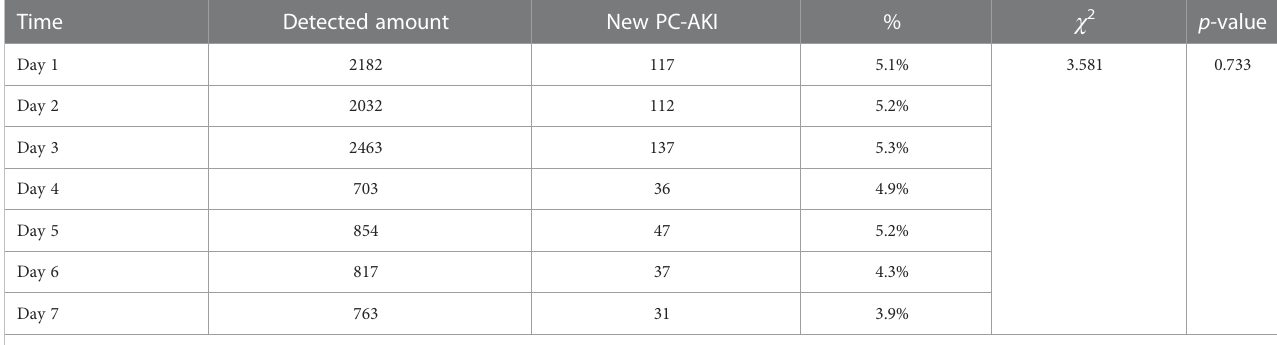
PC-AKI, post-contrast acute kidney injury.